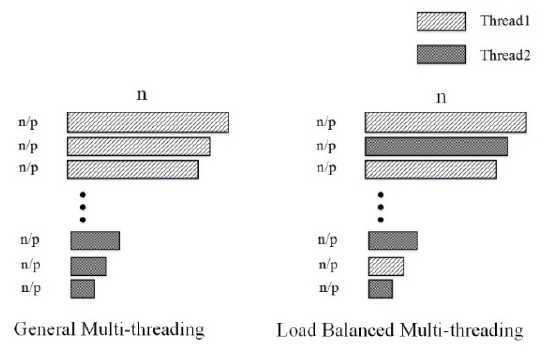
Figure 5. The diagram of general multi-threading and load balanced multi-threading.